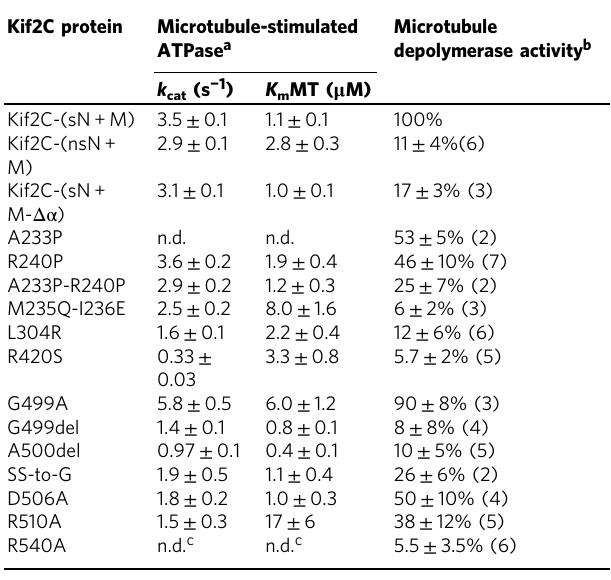
Table 2 Summary of the properties of the Kif2C-(sN+M) mutants studied Kif2C